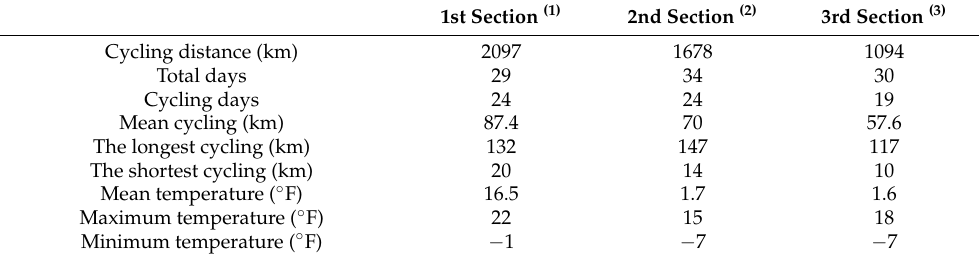
Table 2. Cycling